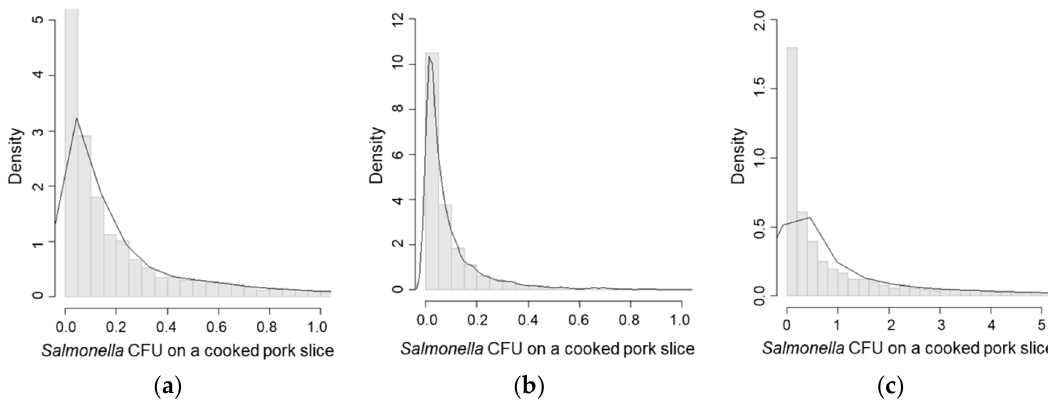
Figure 4. Salmonella CFU/g on a pork slice due to cross-contamination. ( a ) Scenario 1—Washing hands, the knife and the cutting board; ( b ) Scenario 3—Using a new cutting board, disinfecting hands, and washing the knife; ( c ) Scenario 4—Using a new knife, disinfecting hands, and washing the cutting board.